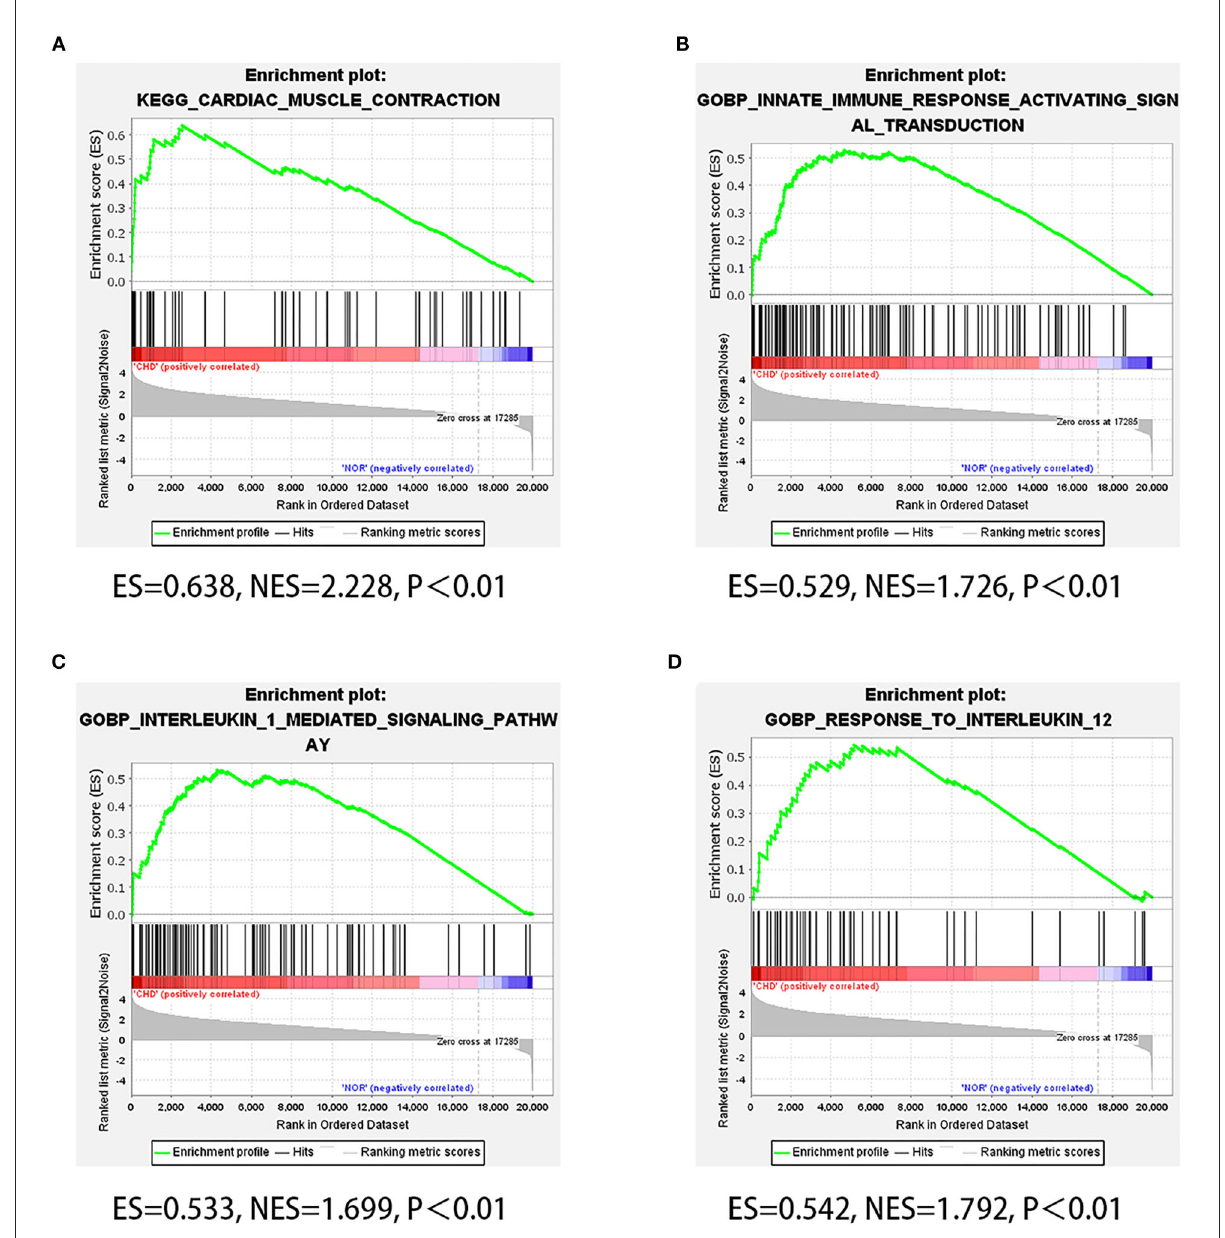
FIGURE4 GSEA of high throughput sequencing dataset. (A–D) Four GSEA plots showing four significant gene sets of PCHD, which respectively are cardiac muscle contraction, innate immune response activating signal transduction, IL-1 mediated signaling pathway, and response to IL-12.